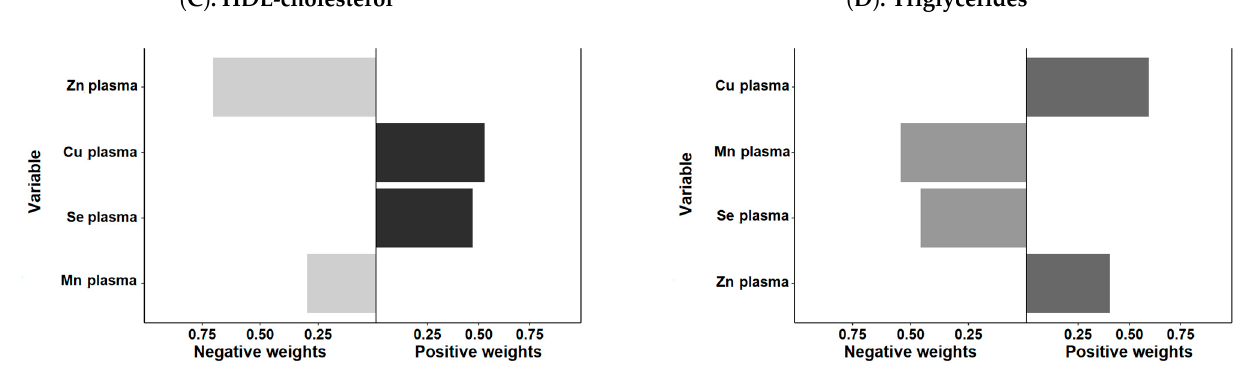
Figure 2. Overall mixture effect estimates and the weights of trace element contributions to the outcome (psi1 beta coefficients, 95% confidence intervals (CI), and p -values) for the combined association of plasma Zn, Cu, Se, and Mn with plasma lipid levels: total cholesterol (panel A ), LDL-cholesterol (panel B ), HDL-cholesterol (panel C ), and triglycerides (panel D ) as continuous variables.